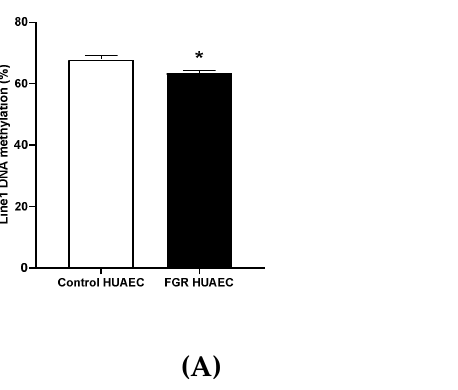
Figure 5. Epigenetic marks of aging in control and FGR human umbilical artery endothelial cells. Average DNA methylation levels ( A ) and representative programs ( B ) of methylated CpG sites from LINE-1 gene in control (open bar, right upper panel) and FGR (solid bar, right lower panel) human umbilical artery endothelial cells (HUAEC). Values are expressed in mean ± SEM.* p < 0.05.